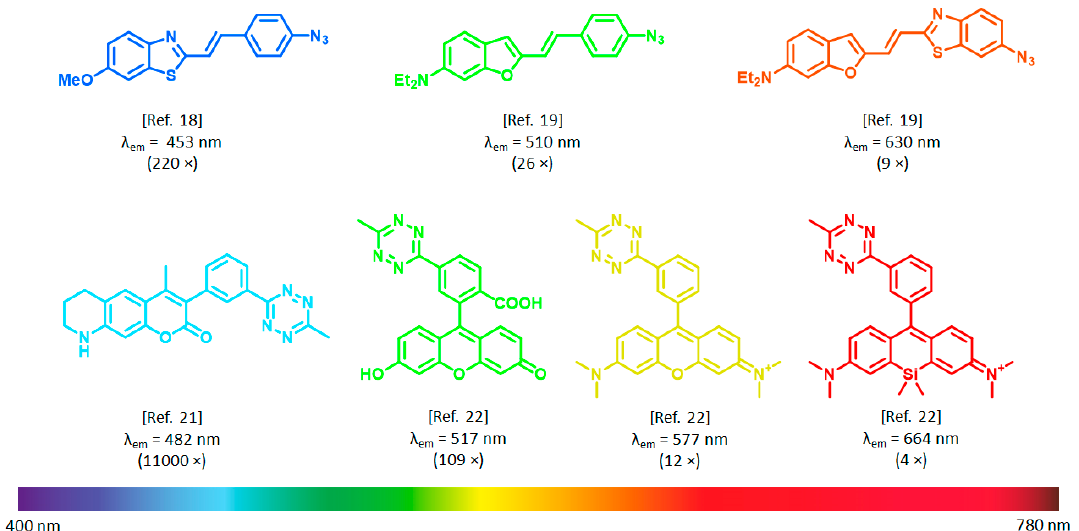
Figure 1. Examples for azide and tetrazine quenched bioorthogonally applicable fluorogenic probes (numbers in parentheses indicate fluorogenicites).